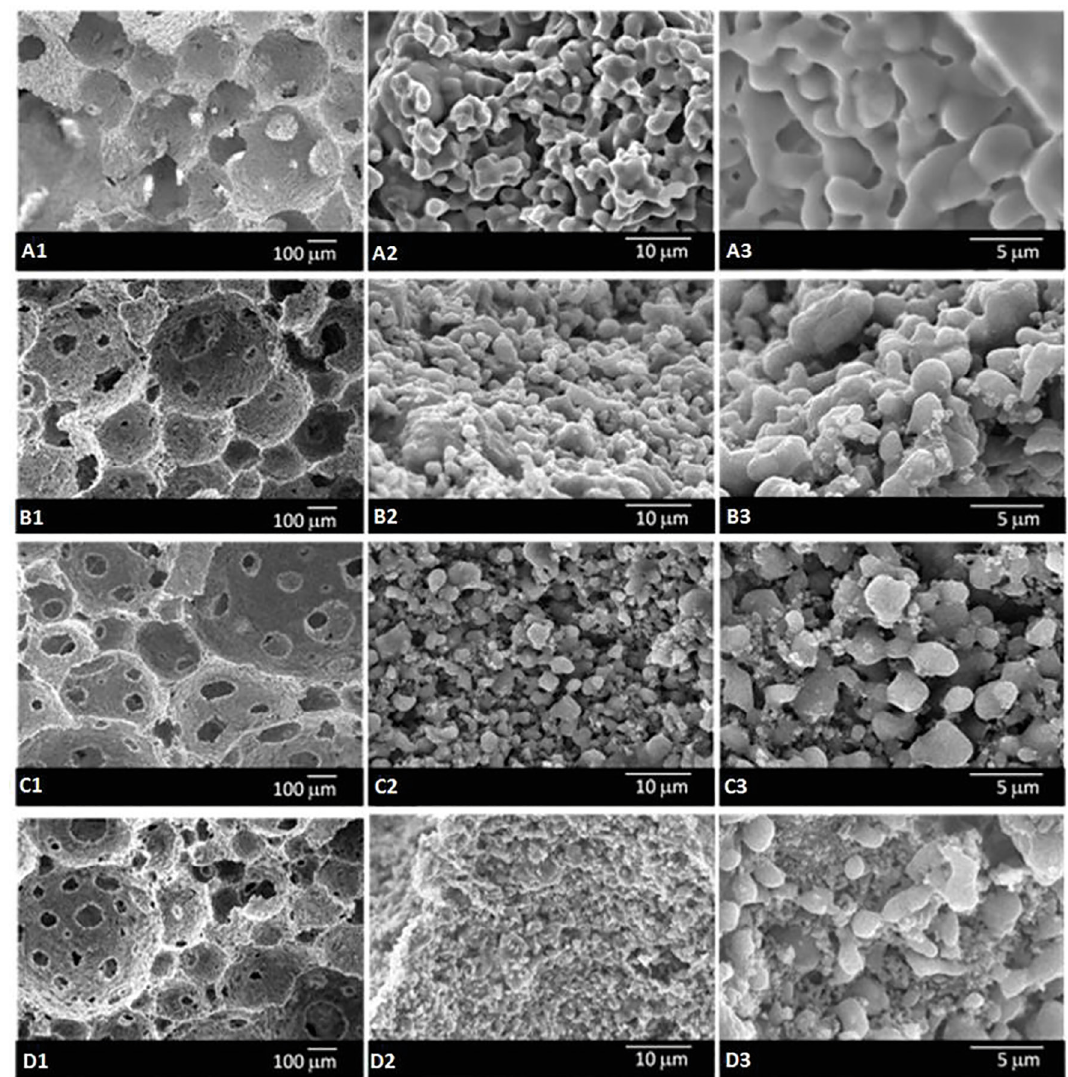
O scaffolds. (A1, A2, A3) β-TCP, (B1, B2, B3) β-TCP/Al 2 3 O – 2 3